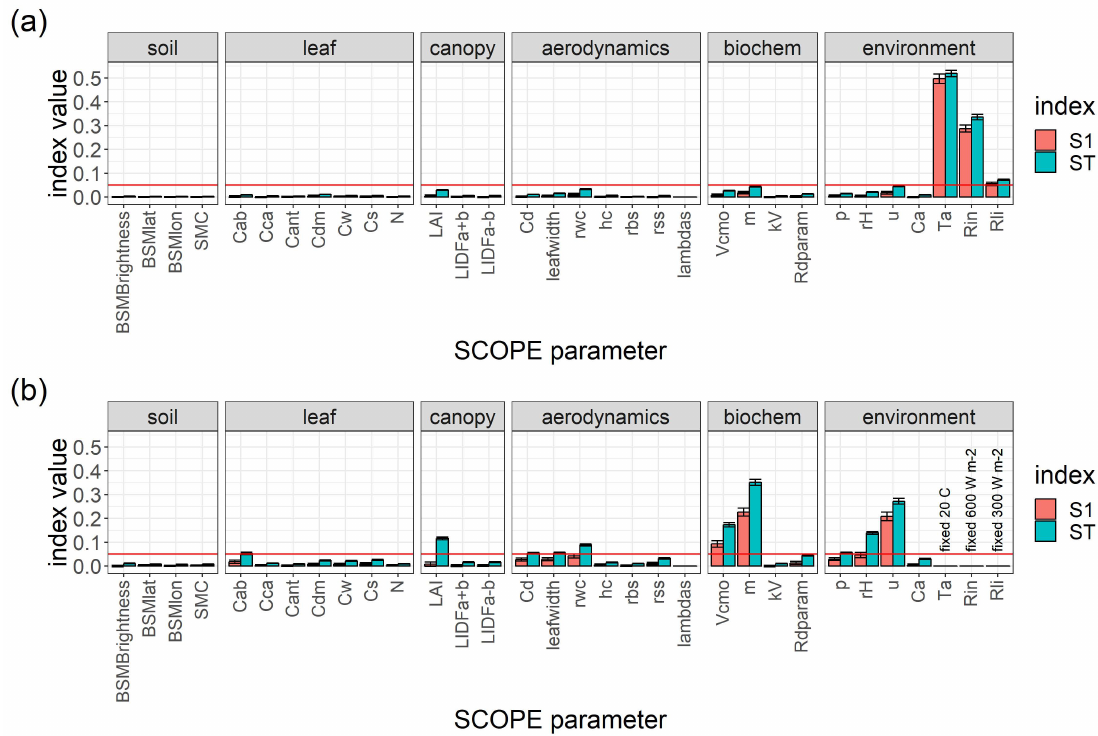
Figure 9. First (S1) and total (ST) order sensitivity indices for land surface temperature (LST) simulated with SCOPE model from Sentinel-3 SLSTR instrument bands S8 (10.9 µ m) S9 (12 µ m). ( a )—varying all parameters, ( b )—fixed air temperature (Ta = 20 ◦ ), total incoming short- and longwave radiation (Rin = 600 W m − 2 , Rli = 300 W m − 2 ). Red horizontal line denotes the significance threshold (0.05 units of index value). Definitions of parameters can be found in Table